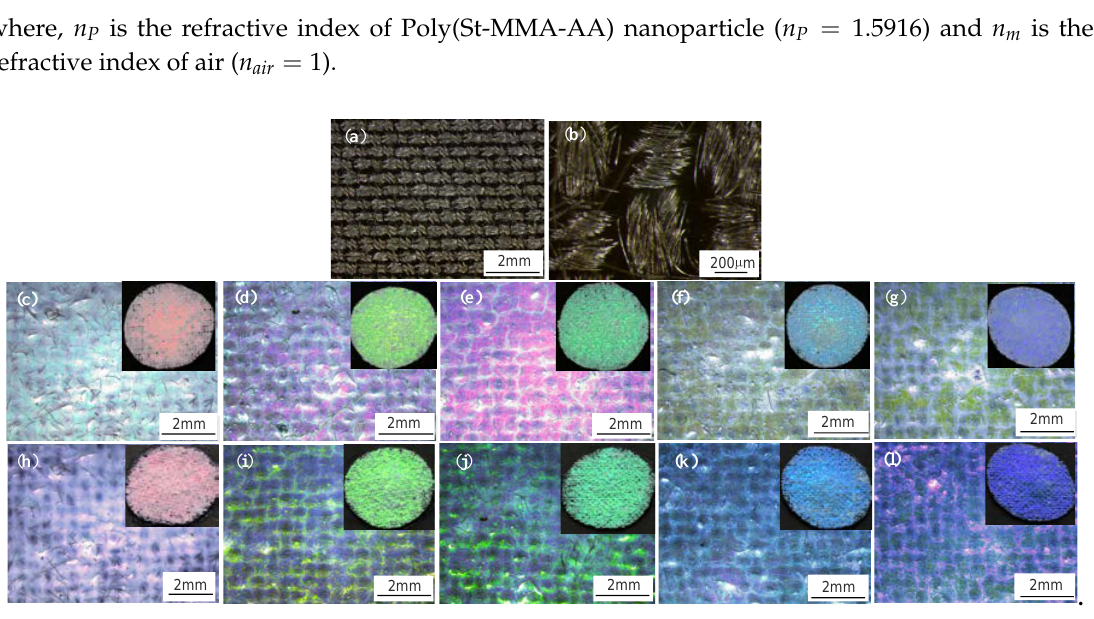
Figure 5. Optical microscope images of plain-weave carbon fabrics with magnification of ( a ) 160× and ( b ) 1000×. ( c – g ) Optical micrographs of Poly(St-MMA-AA)/PCFs before dipping treatment. (Particle diameters from (c) to (g): 308.3, 262.4, 249.7, 234.1, and 213.1 nm). (Magnification: 160×). ( h – l ) The corresponding optical micrographs of poly(St-MMA-AA)/PCFs after dipping treatment. (Particle diameters from (h) to (l): 308.3, 262.4, 249.7, 234.1, and 213.1 nm). Magnification for (c) to (l): 160×). The insert showed corresponding optical images of carbon fabrics deposited with poly(St-MMA-AA) particle with diameters of 308.3, 262.4, 249.7, 234.1, and 213.1 nm.